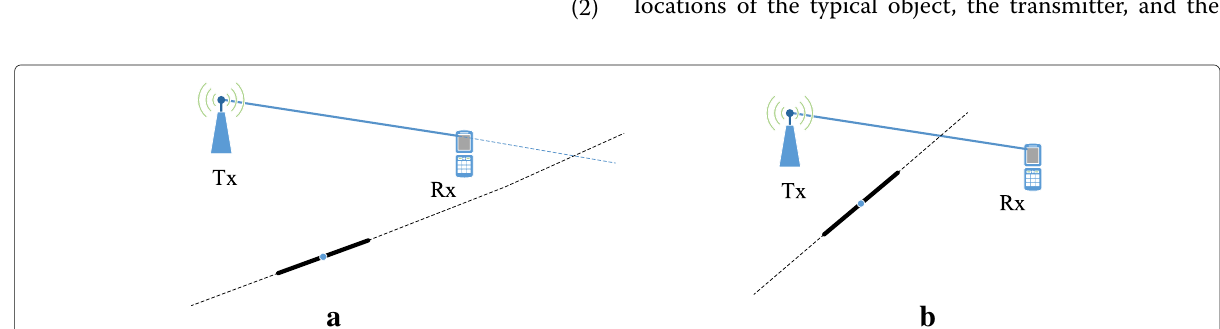
Fig. 3 Illustration of Event 1 based on Approach 4.1.1. a Event 1 holds true if the intersection point between the infinite lines falls outside the Tx-Rx line segment. b Otherwise, Event 1 does not hold